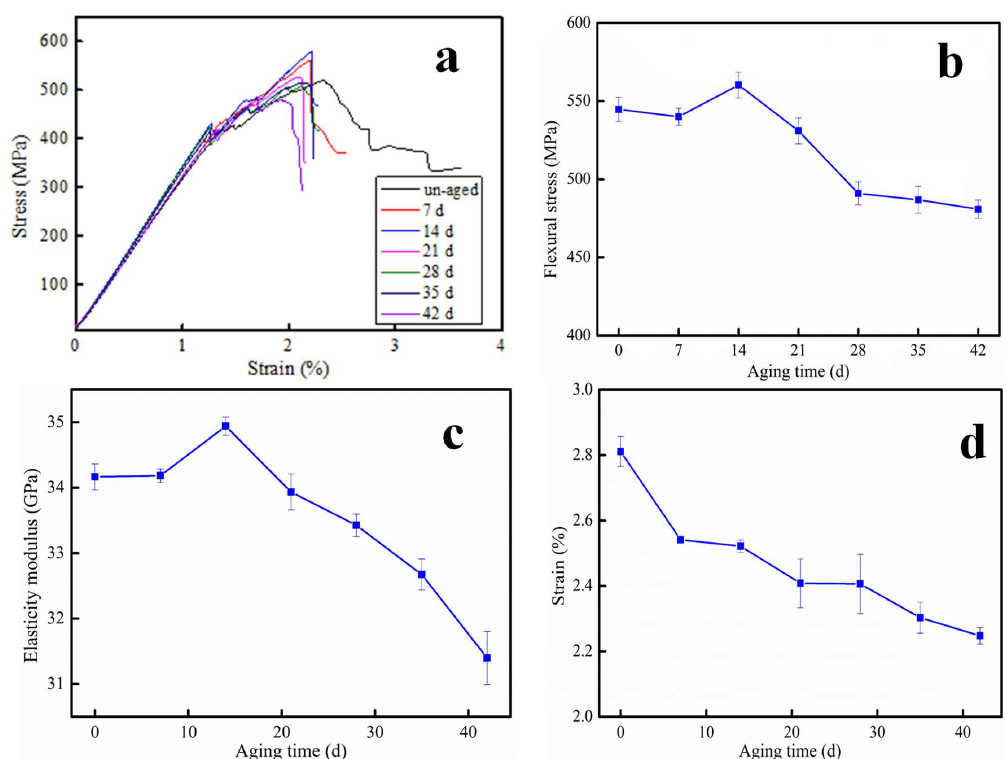
Figure 6. Flexural properties for CF / PC composites as a function of aging time. ( a ) the representative stress-strain curves of CF / PC composites with di ff erent hydrothermal aged, ( b ) flexural stress of CF / PC composites with di ff erent hydrothermal aged, ( c ) elasticity modulus with di ff erent hydrothermal aged, ( d ) strain with di ff erent hydrothermal aged. 1 mm /